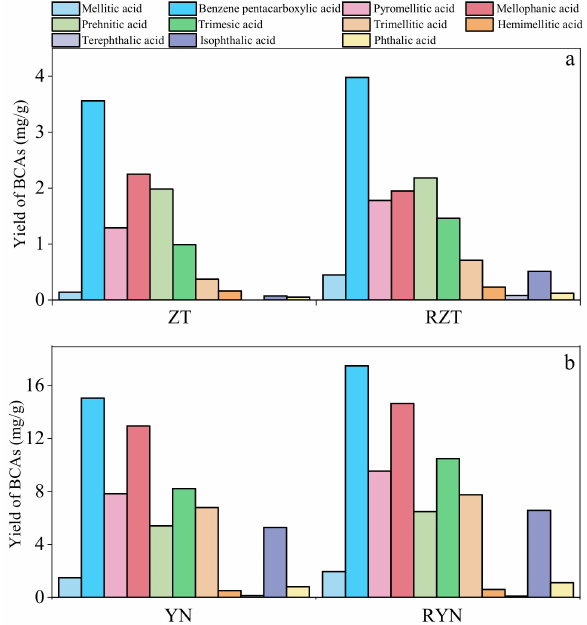
Figure 3. Yield of BCAs in resulting products from ZT and RZT oxidation ( a ) and YN and RYN oxidation ( b ).